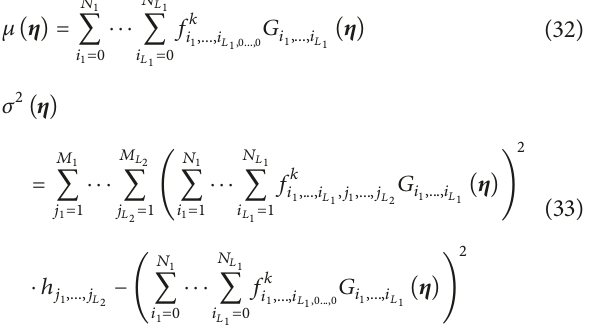
Figure 3, a rigid two-dimensional sound tube finite element model is built and intermittent loads are applied to the inside of the